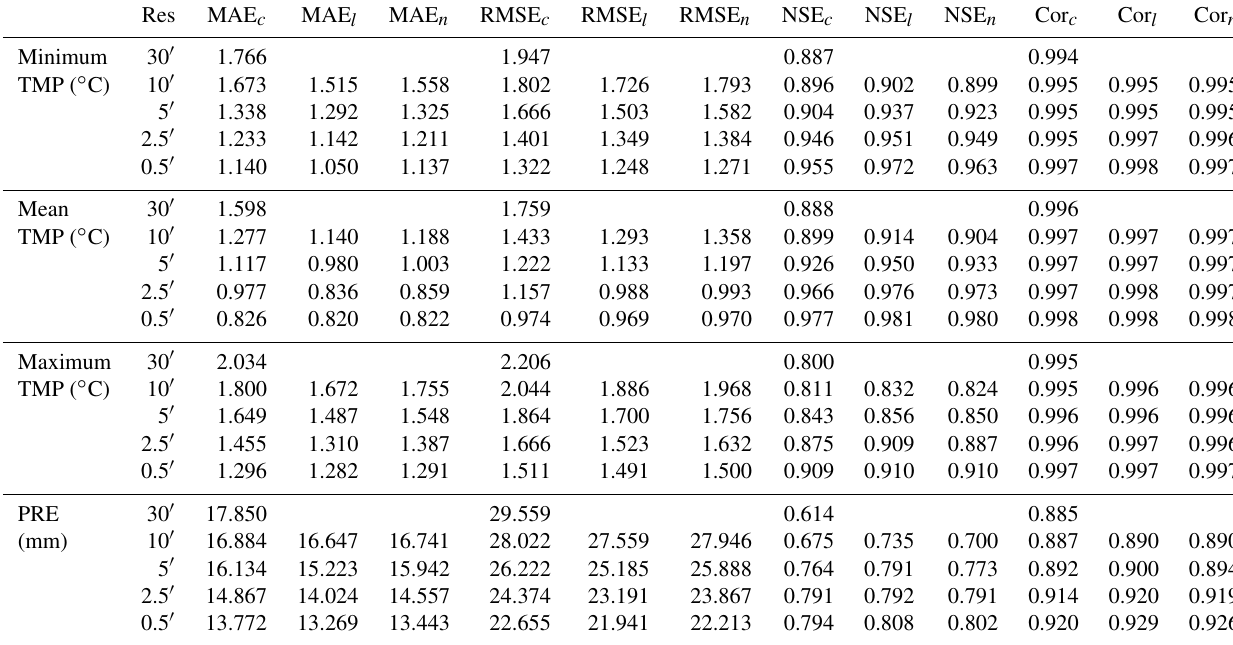
Table 3. Statistical characterization of original–downscaled and observed monthly TMPs and PRE in the time series (1951–2016). The values shown here are the averaged evaluation results at all independent weather stations, with standard errors listed in Table S1.